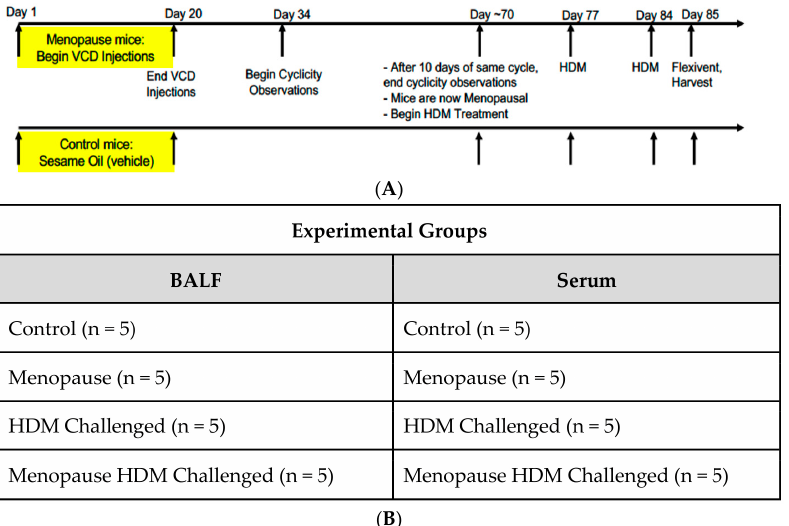
Figure 1. Experimental setup. ( A ) Timeline of the VCD/HDM model denoting times of VCD dosing, cyclicity checking, HDM dosing, Flexivent and tissue harvest. ( B ) Table denoting the four experimental groups, as well as n values per group.